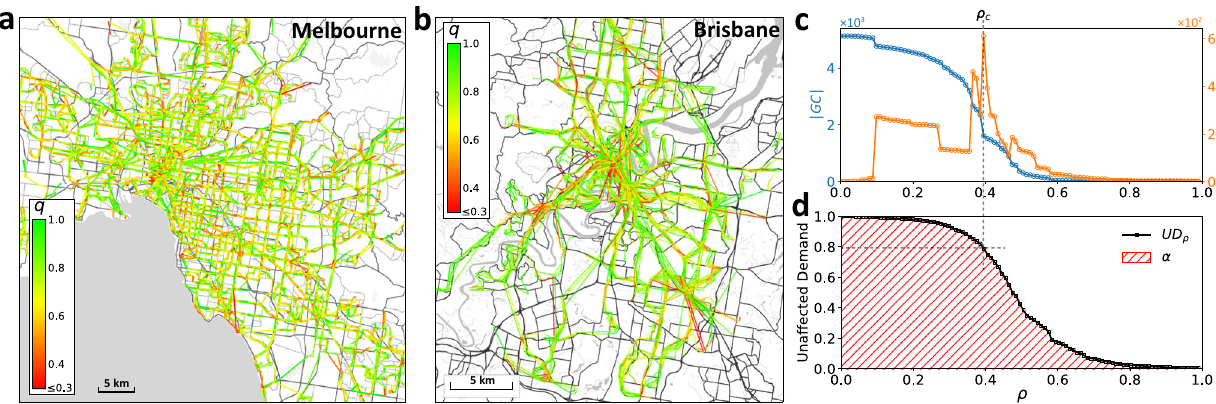
Fig. 2 Real on-road public transportation (PT) networks. a , b The network representation of the PT system with color-coded link qualities q at t = 8 (8:00 A.M.), for Melbourne on 1 September 2017 ( a ), and for Brisbane on 1 March 2013 ( b ). c Percolation process on Melbourne ’ s network shown in ( a ). The size of the giant component ∣ GC ∣ and the size of the second-largest component ∣ SC ∣ are plotted as functions of the threshold ρ . The critical threshold ρ = ρ c is determined as the point of maximal ∣ SC ∣ (vertical dashed gray line). d Percolation process on Melbourne ’ s network shown in ( a ). Unaffected demand is (cid:1) 0 : 8 (marked by dashed gray lines). The area hatched in plotted as a function of ρ (UD ρ ) which at percolation critical threshold shows the value of UD ρ c red corresponds to the reliability α of the network in ( a ). Streetmap layers in a and b ©OpenStreetMap contributors 44